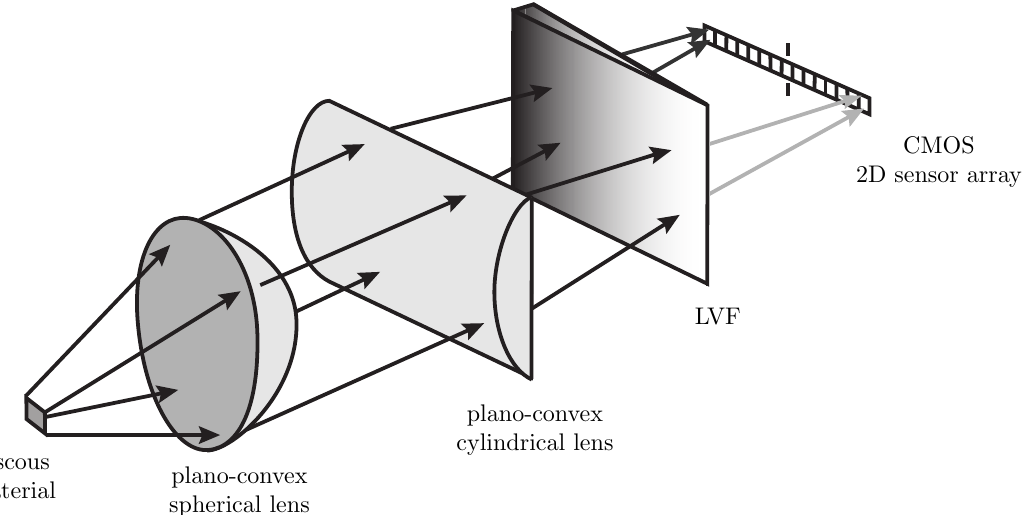
Figure 1. Representation of the described idea. The UV light source illuminates the viscous material (not in the figure). The resulting fluorescence of the measurement